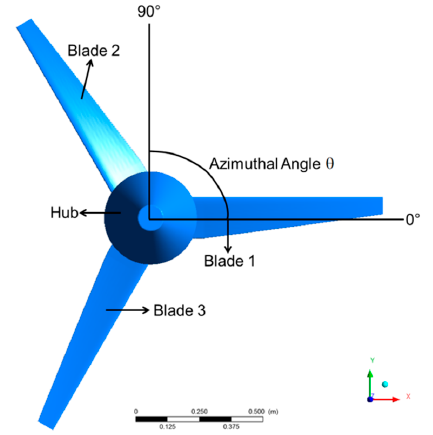
Figure 4. The rotor view illustrating the blades’ position and the employed coordinate system. Blades rotate counterclockwise. Blades rotate